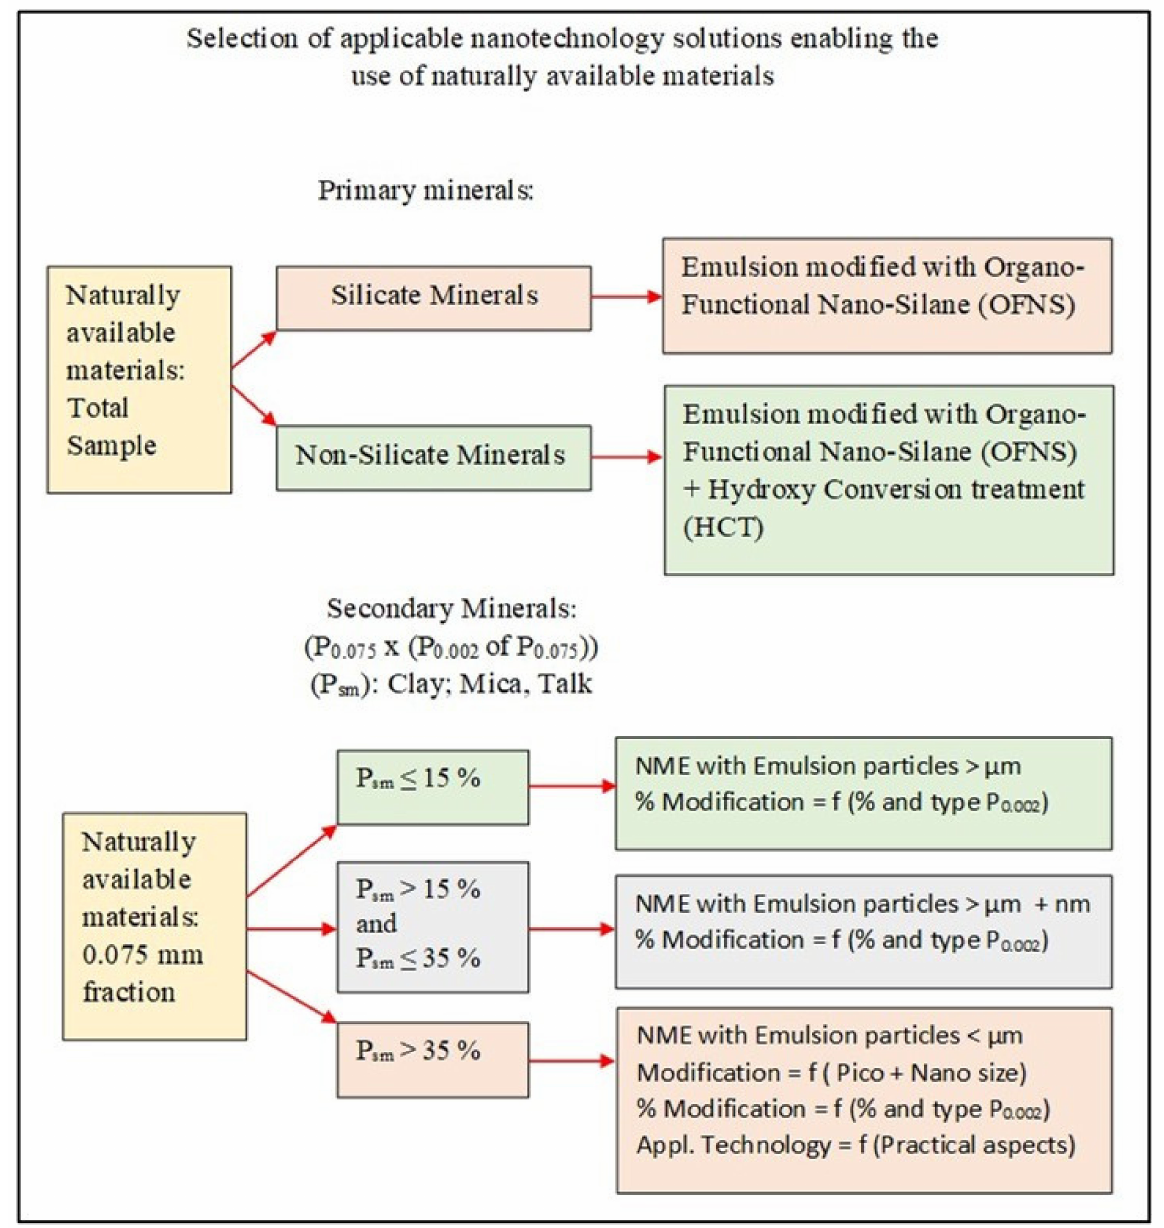
Figure 17. Required information as an input to the selection of a material-compatible Nano-Modified Emulsion